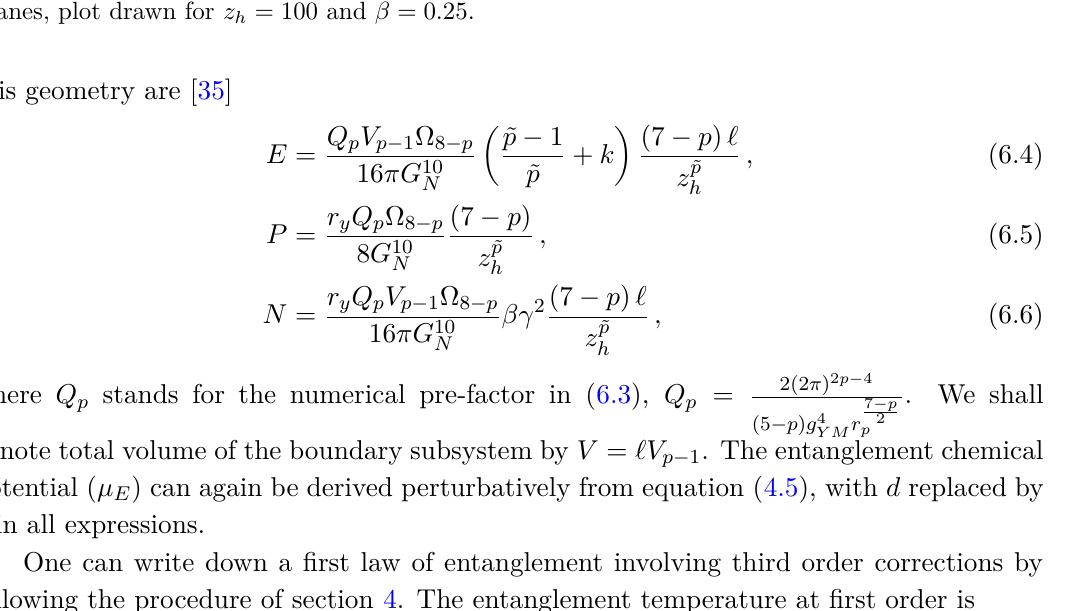
Figure 4. The entanglement temperature with and without higher order corrections of D2 and D4 branes, plot drawn for z h = 100 and β = 0 . 25